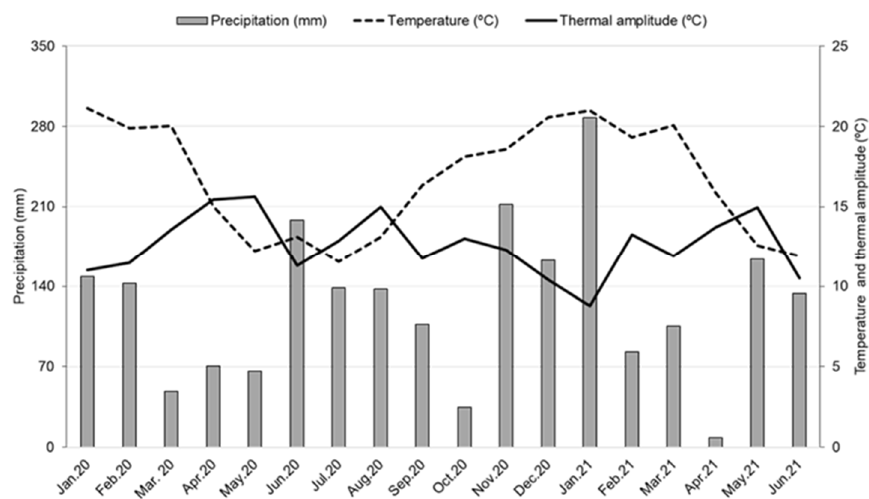
Figure 1. Monthly precipitation (mm), air temperature (°C), and thermal amplitude (°C) from the field experiment, Curitibanos, SC, Brazil (January 2020 to June 2021). Data were obtained online: https://ciram.epagri.sc.gov.br (accessed on 23 August 2021).